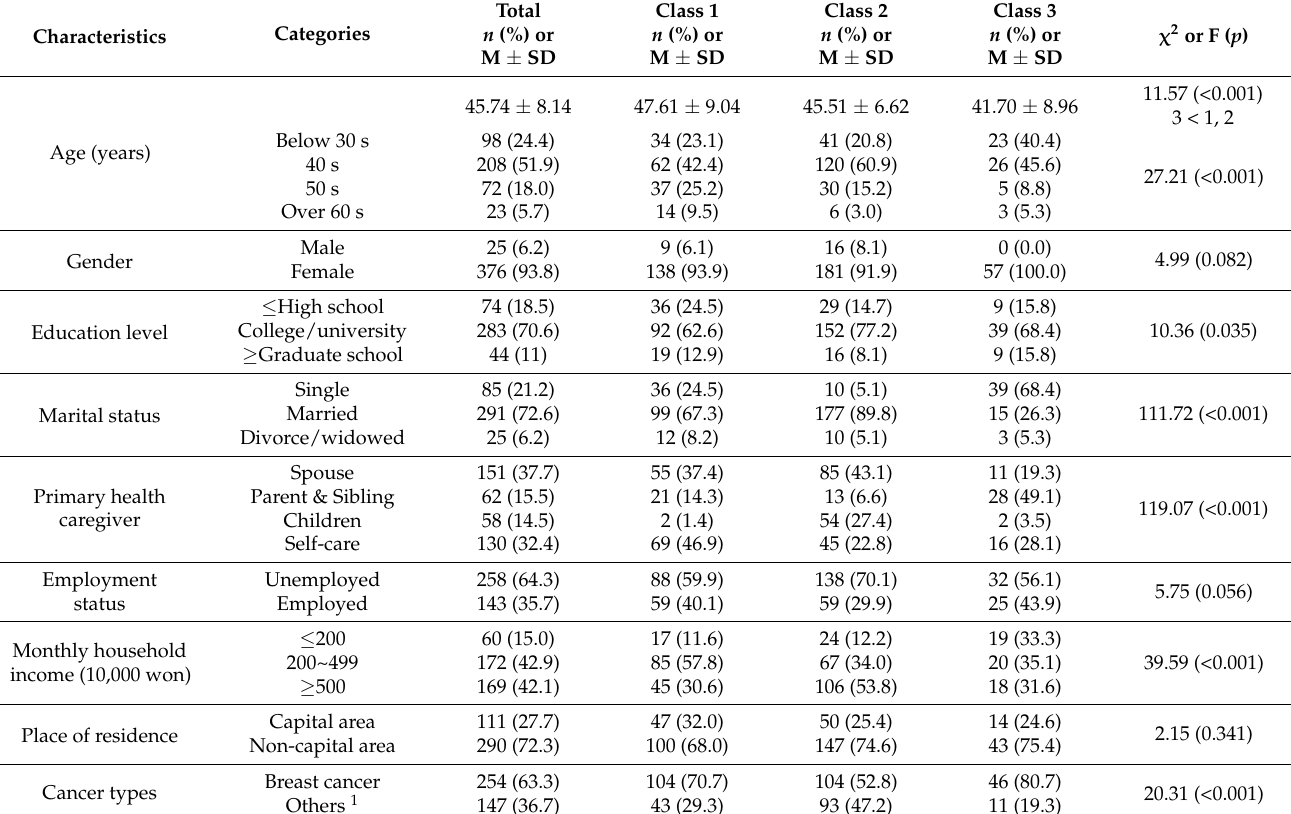
Table 5. Differences in the characteristics of participants according to the profile group ( N =